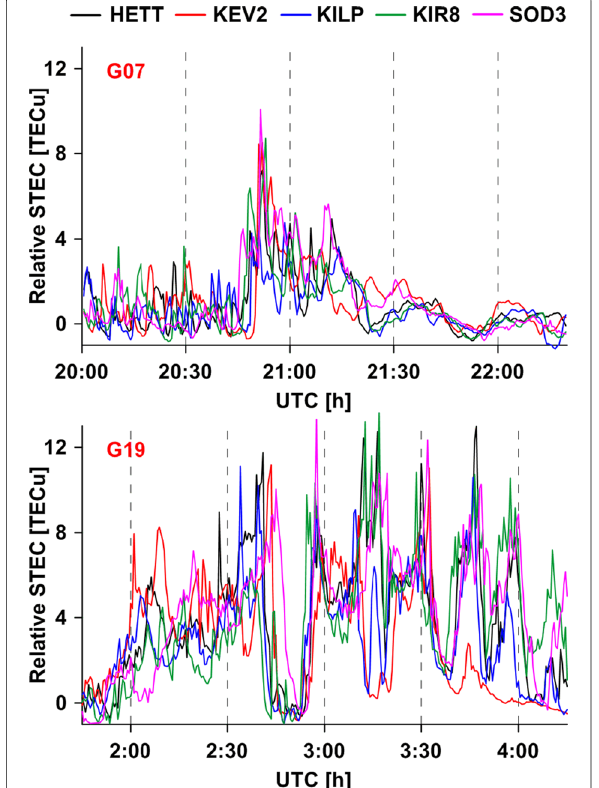
Fig. 4 The relative STEC values for all stations used in the positioning experiment. Top panel satellite GPS PRN 7 on August 25; bottom panel satellite GPS PRN 19 on August 26